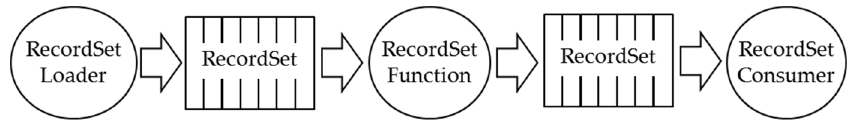
Figure 4. A description of a RecordSetOperator in Marmot: RecordSetLoader, RecordSetFuntion, and RecordSetConsumer.